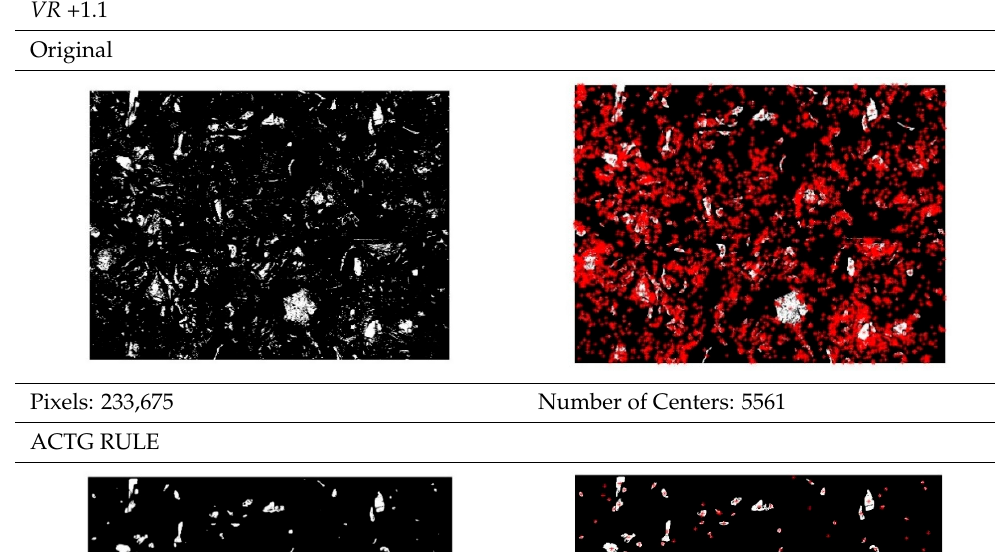
Table A4 . Images and associated pixels and number of centers corresponding to VR = +1.1. VR +1.1